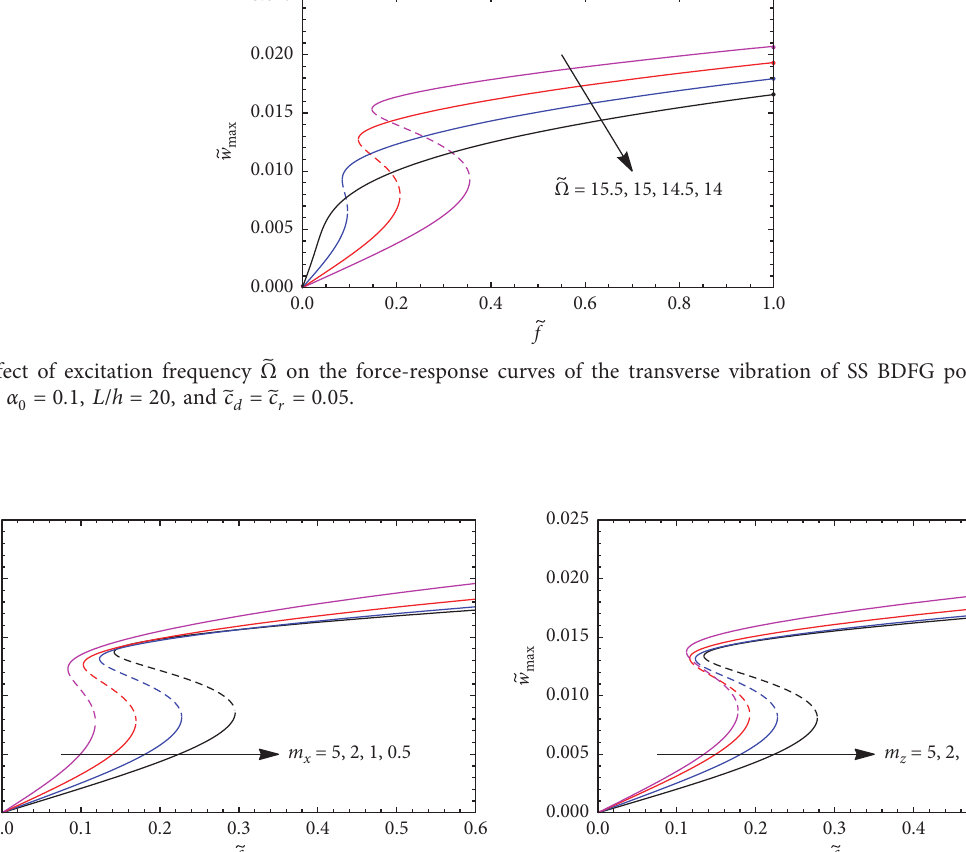
� 􏽥 c � 0 . 05, and 􏽥 f � 0 . 2. (a) m d r